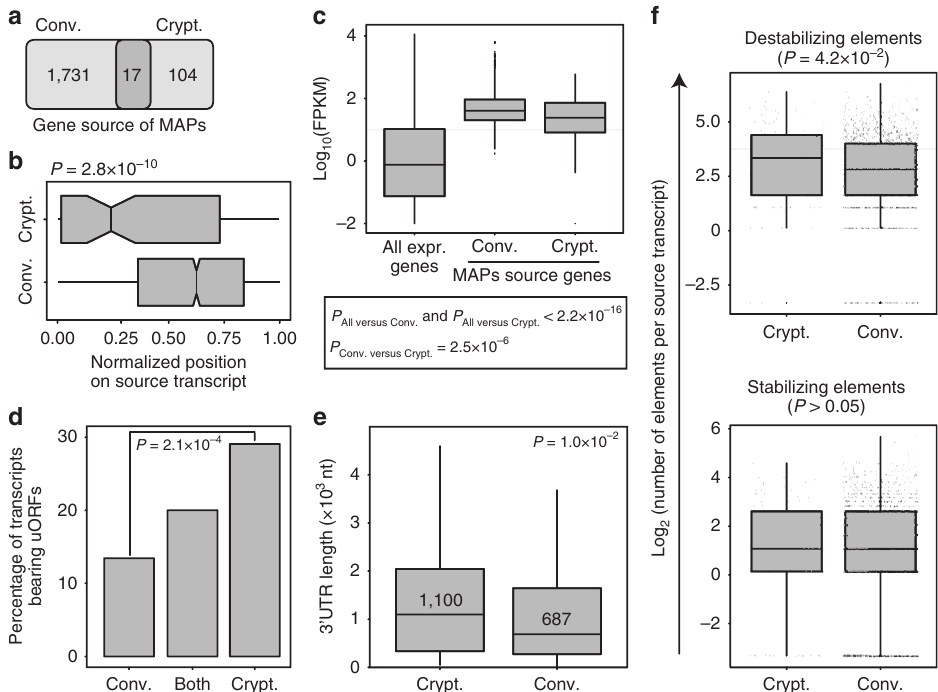
Figure 4 | Crypt. MAPs preferentially derive from unstable mRNAs. ( a ) Venn diagram showing minimal overlap between the gene source of Conv. and Crypt. MAPs. ( b ) Crypt. MAPs preferentially derive from the 5 0 end of their source transcript. The length of each source transcript was normalized to 1, and the start of each MAP was then positioned on a 0–1 scale ( x axis), where 0 represents the 5 0 end of the source transcript. Crypt. MAPs deriving from intergenic and intronic regions were excluded from this analysis. See also Supplementary Fig. 5a. ( c ) Log 10 expression values, in FPKM, of all genes expressed in B-LCL versus the subset of the gene source of Conv. and Crypt. MAPs. ( d ) Crypt. source transcripts preferentially bear upstream ORFs (uORFs). For each MAP source transcript, we predicted the 5 0 UTR and 5 0 UTR–exon ORF initiating at an AUG embedded in an optimal or strong Kozak context. The bar graph shows the proportion of source transcripts bearing at least one uORF and generating a Conv. MAP, a Crypt. MAP or both. See